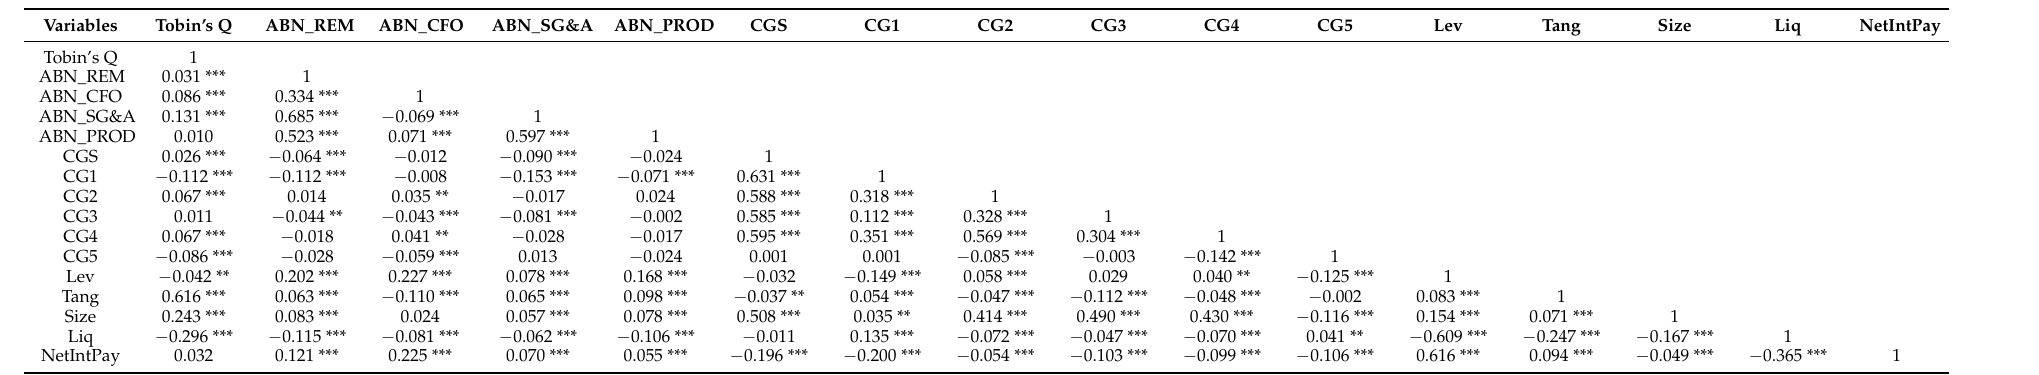
Table 2. Pearson Correlation